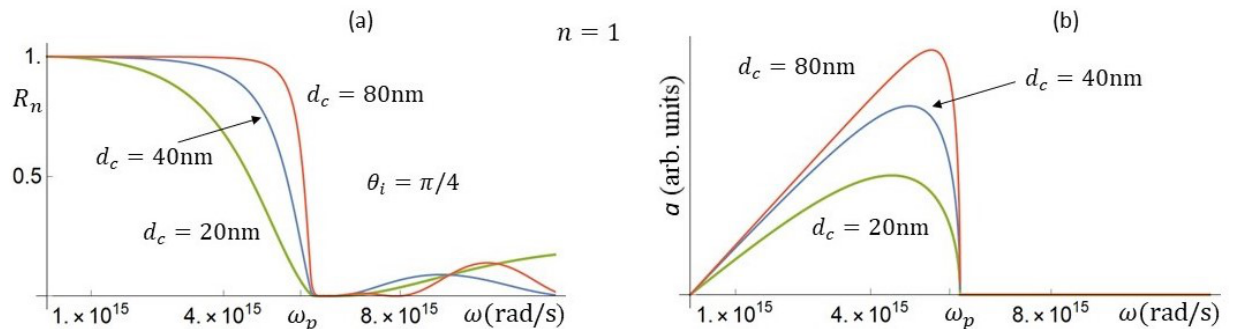
Figure 17. Reflection and absorption factor for a single layer when the incidence angle is θ i = π /4. In subfigure ( a ), the reflection coefficient as function of the frequency, for different thicknesses of the silver layer. In subfigure ( b ), the absorption factor a grows as the layers’ thicknesses d c increase. The absorption factor vanishes at ω = 0 and ω = ω p , and its maximum shifts to higher frequencies as d c grows.